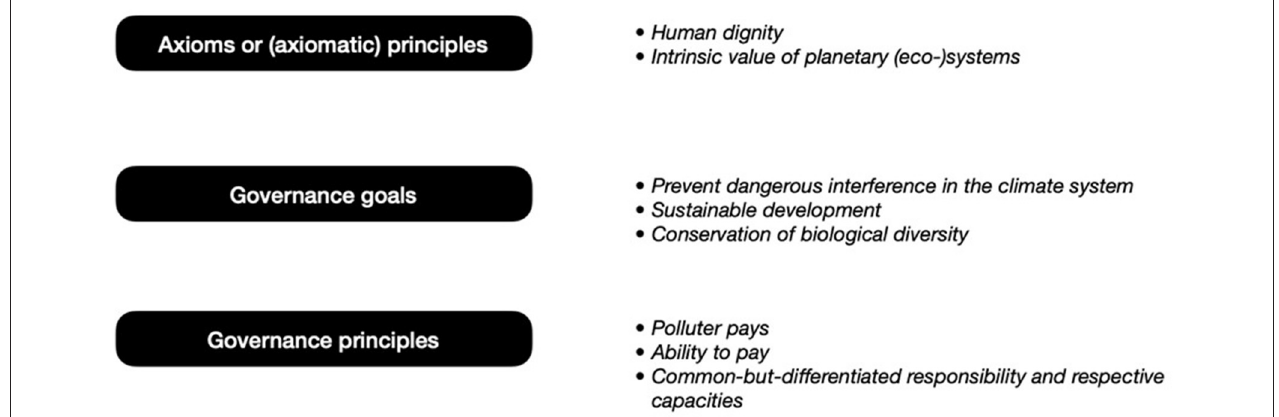
FIGURE 1 | The conceptual framework and context of “governance principles” with